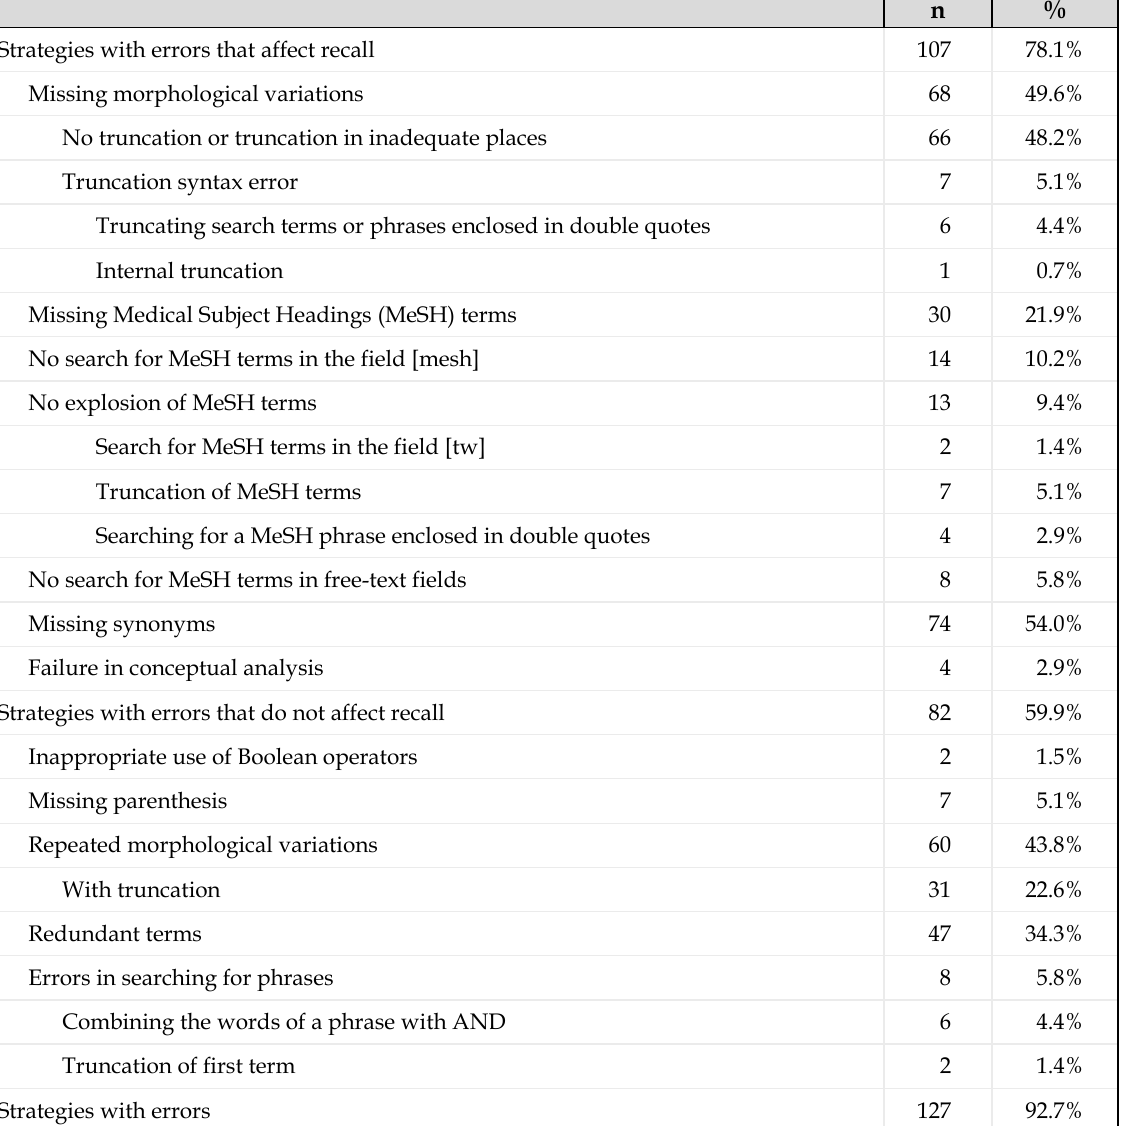
Table 1 Frequency and types of errors in MEDLINE/PubMed search